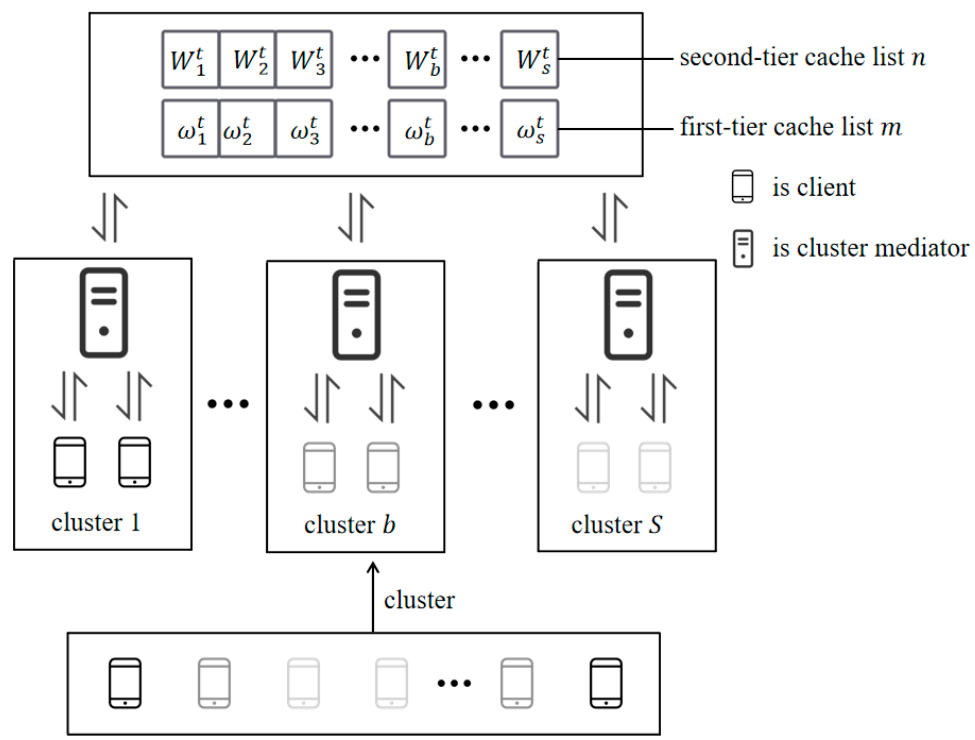
Figure 1. Structure of FedTCM. FedTCM mainly includes clusters and a server. Clients with different colors denote that the clients have different data distributions. The cluster consists of clients and a cluster mediator. The server contains a first-tier cache list m and a second-level cache list n . At the same time, we design a two-tier caching mechanism on the server side. Each cluster corresponds to one location in the first-tier cache and one in the second-tier cache, respectively. When the cluster calculation is completed, the model is sent to the server. The server updates the corresponding locations in the first-tier cache and the second-tier